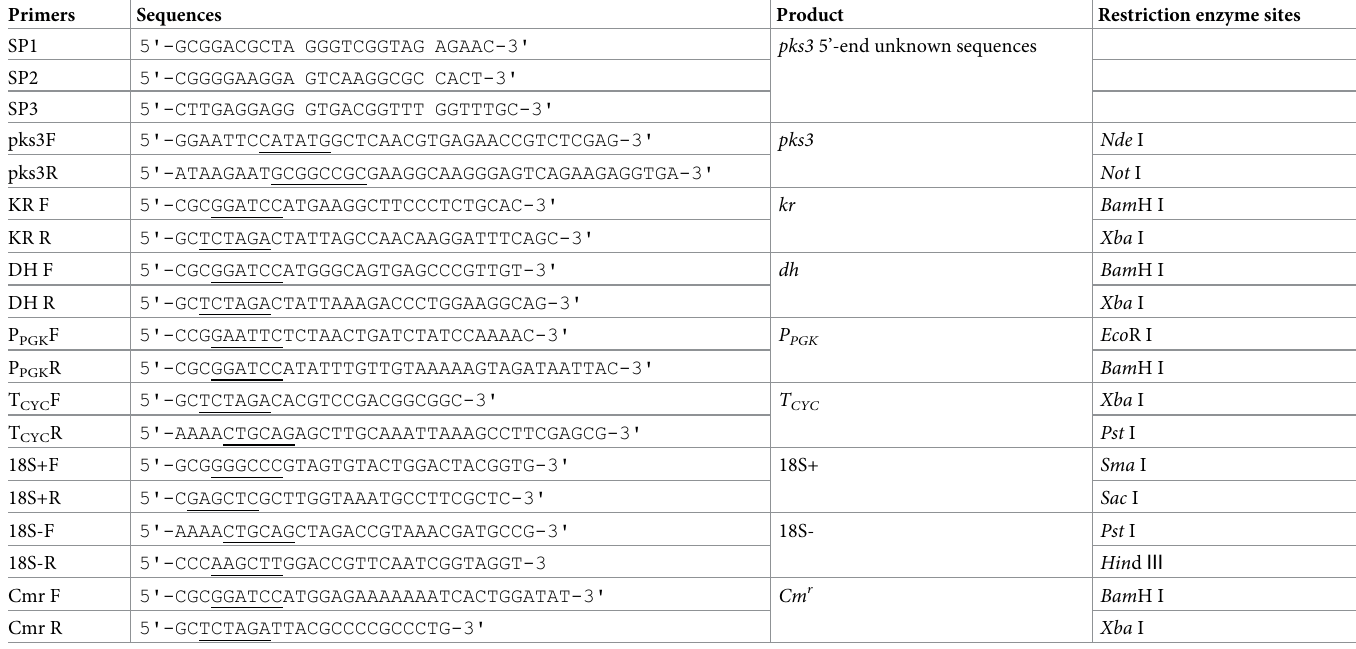
Table 1. Primers used in this study(underlined in the primer sequences were restriction enzyme sites). Primers